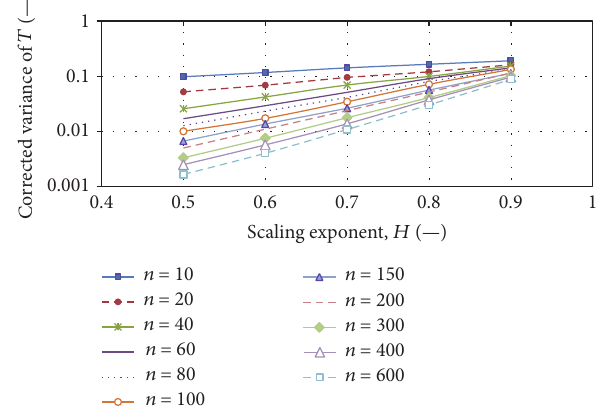
Figure 10: Variance of the CRD test statistic ( T ) corrected for the influence of long-term persistence considering various values of 𝑛 and 𝐻 .